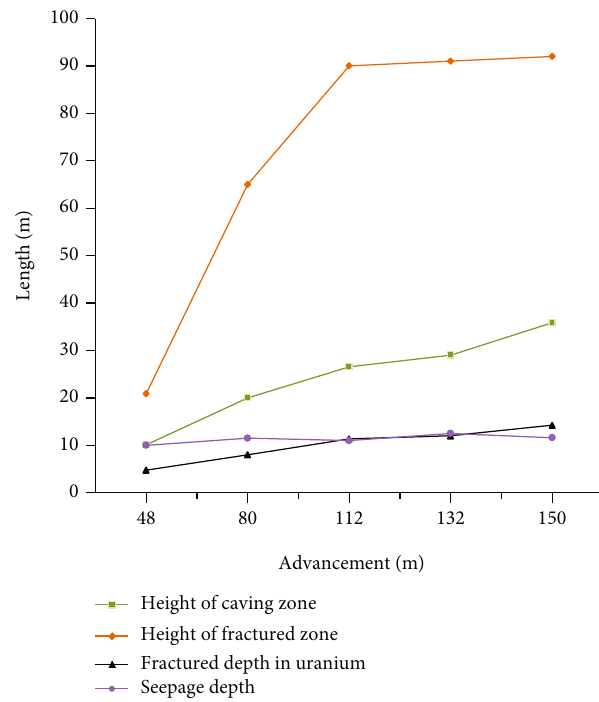
Figure 7: Correlation between the coal mining and development of the fracture and seepage